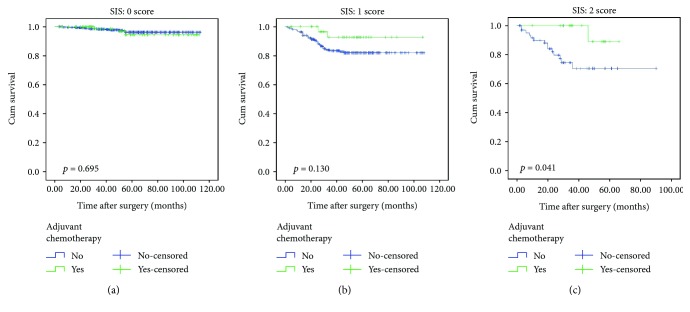
Comparison of OS between adjuvant chemotherapy group and surgery-only group. (a) 0 score subgroup, (b) 1 score subgroup, and (c) 2 score subgroup.